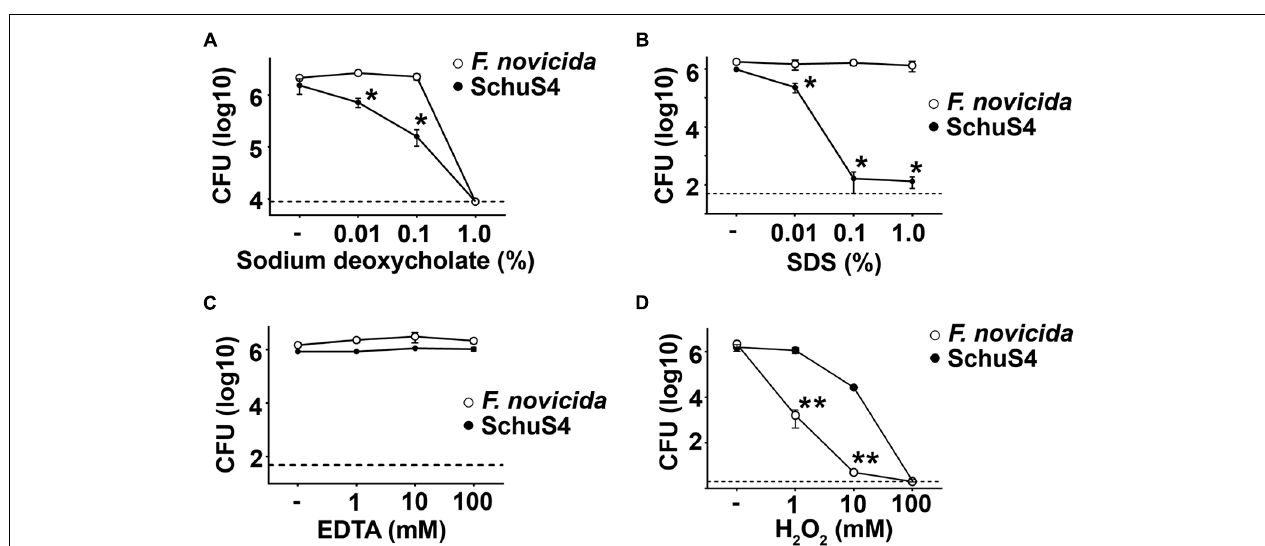
FIGURE 2 | Francisella novicida exhibits greater sensitivity to H 2 O 2 than SchuS4. Bacteria (10 6 /ml) were added to solutions of (A) sodium deoxycholate, (B) SDS, (C) EDTA, or (D) H 2 O 2 incubated at 37 ◦ C for 2 h. Then, bacteria were serially diluted and plated on MMH agar to